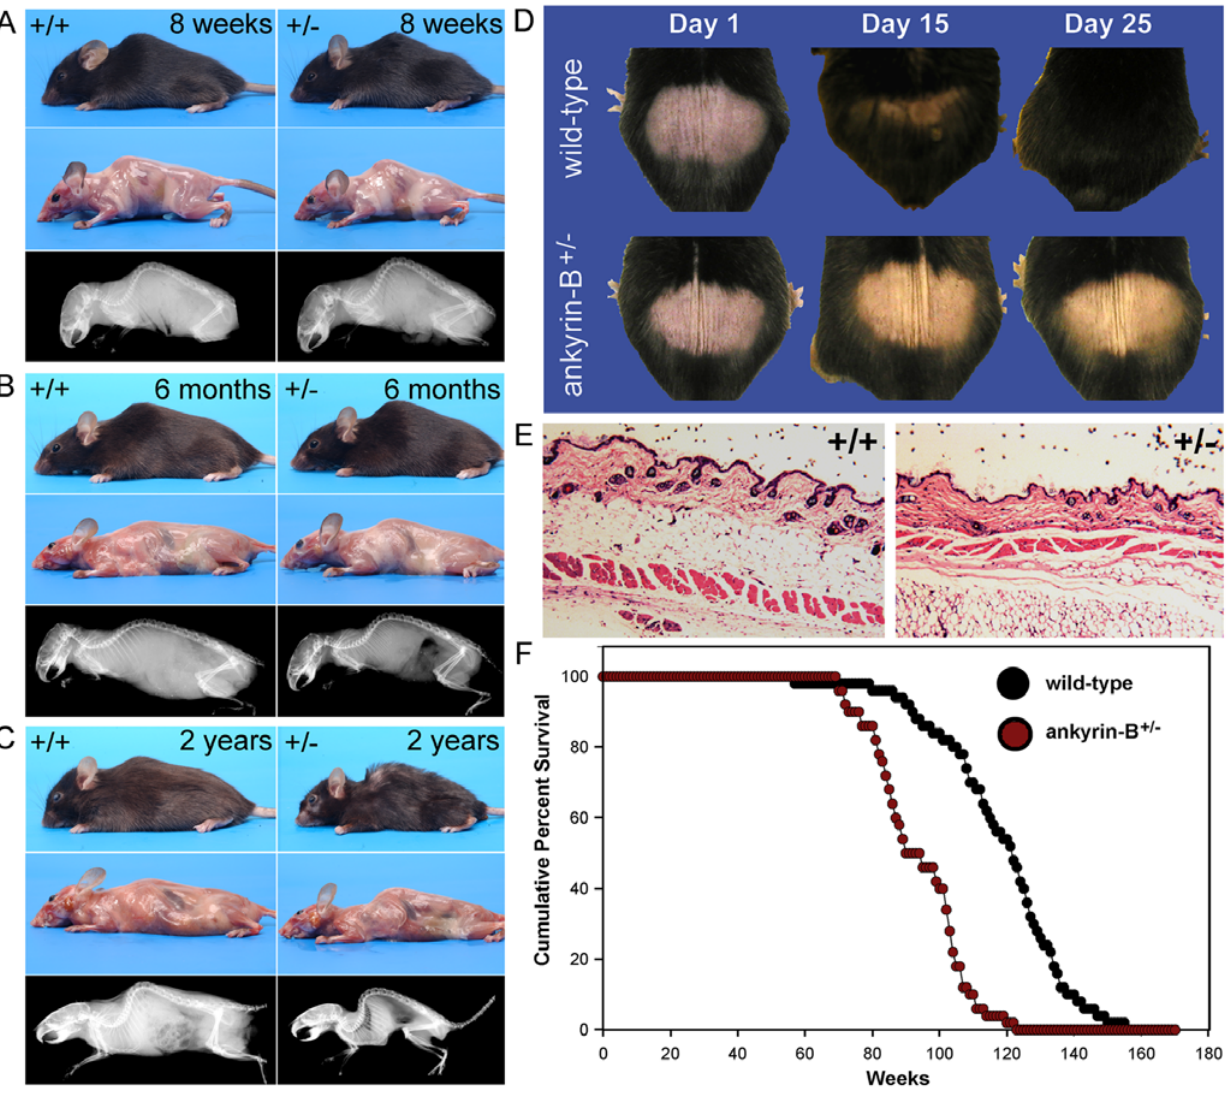
Figure 4. Ankyrin-B + / 2 mice display premature senescence and reduced longevity. Gross phenotypes of wild-type and ankyrin-B + / 2 mice at (A) eight weeks, (B) six months, and C) two years. While we observe no major differences in phenotypes at eight weeks, we observe a slight decrease in size and the presence of lordokyphosis in ankyrin-B + / 2 mice at six months of age. At two years, unlike wild-type littermates, living ankyrin-B + / 2 mice display a significant decrease in adiposity and loss of soft tissues as well as prominent lordokyphosis. D, Dorsal hair regrowth phenotypes in 12 month C57Bl/6 wild-type and ankyrin-B + / 2 littermates. We observed no difference in regrowth in 1 or 3 month mice. E, H&E stain of dorsal skin sections from age-matched (24 month) wild-type and ankyrin-B + / 2 littermates. Note the decrease in adipose from the subdermis of ankyrin-B + / 2 mouse skin. F, Reduced longevity of ankyrin-B + / 2 mice compared with wild-type littermates.